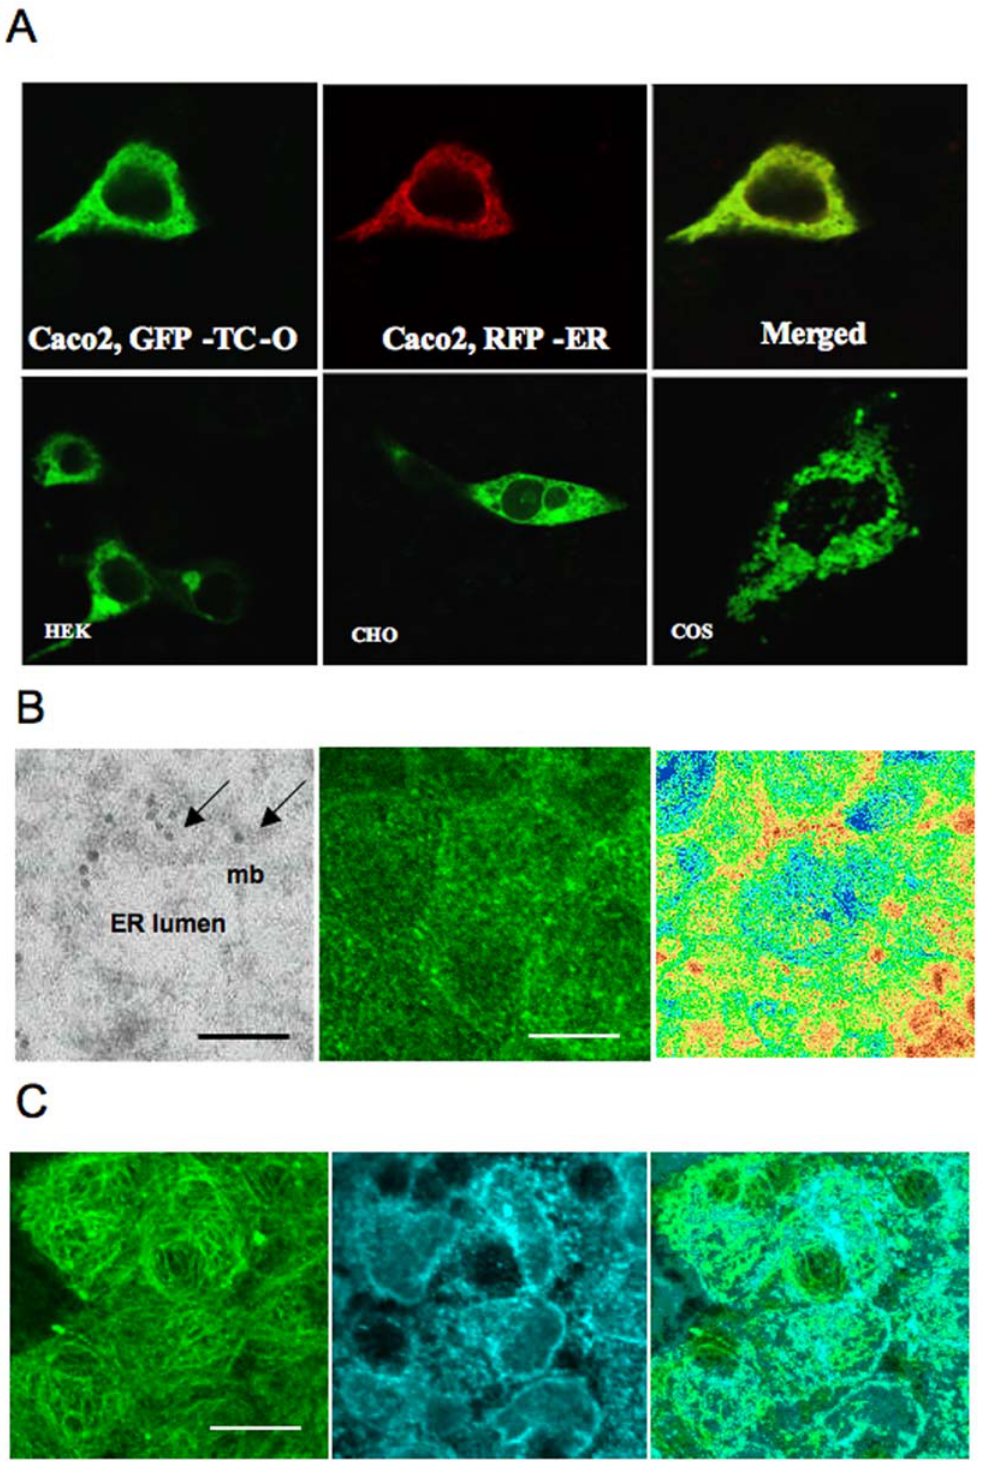
Figure 4. (A) Confocal microscopic examination of the localization of the green fluorescent protein-transcobalamin-oleosin (GFP-TC-O) chimeric protein 24 hrs after transient transfection of Caco2, human embryonic kidney cells (HEK293), Chinese hamster ovary (CHO) and COS-7 cells. In Caco2 cells, GFP-TC-O co-localization was detected with an ER-targeted red fluorescent protein (pDsRED2-ER, Clontech USA) (merged). (B) Left: Transmission electron microscope examination of the chimera detected immunologically by a Gold conjugate (arrows) (left). Calibration bar=0.1 m m. Abbreviations: mb, membrane, ER, endoplasmic reticulum. Middle: confocal image of immunolabeling of megalin in apical surface of O-TC caco-2 cells. Right: relative fluorescence intensity (low, red; high: blue) of megalin on apical area. Calibration bar=18 m m. (C) Left and middle: Confocal image of immunolabeling of megalin (Alexa488 coded in green, left channel) and calnexine (Alexa555 coded in cyan, right channel). Right: Merged. Calibration bar=18 m m.